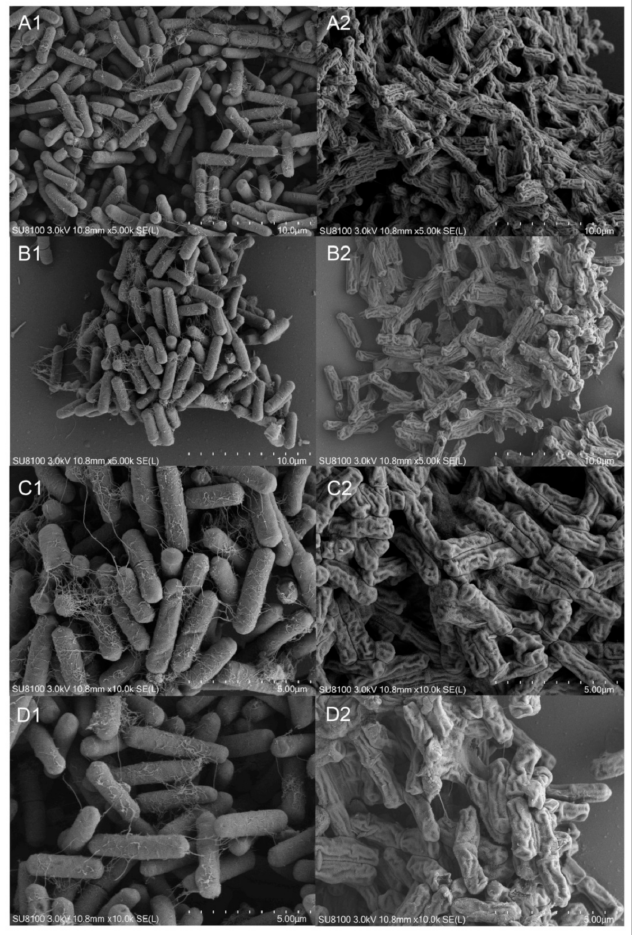
Figure 5. Morphology and structure alterations of HBA-treated A . avenae subsp. citrulli observed by SEM. Note: ( A1 , B1 ): The control A. avenae subsp. citrulli with 5000 times. ( C1 , D1 ): The control A. avenae subsp. citrulli with 10,000 times. ( A2 , B2 ): The treated A. avenae subsp. citrulli with 5000 times (125 µ g/mL). ( C2 , D2 ): The treated A. avenae subsp. citrulli with 10,000 times (125 µ